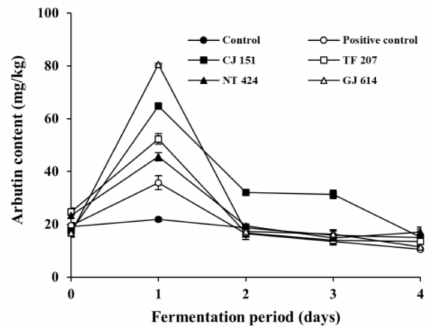
Figure 3. Changes in arbutin content in soybeans fermented with arbutin-producing B. subtilis